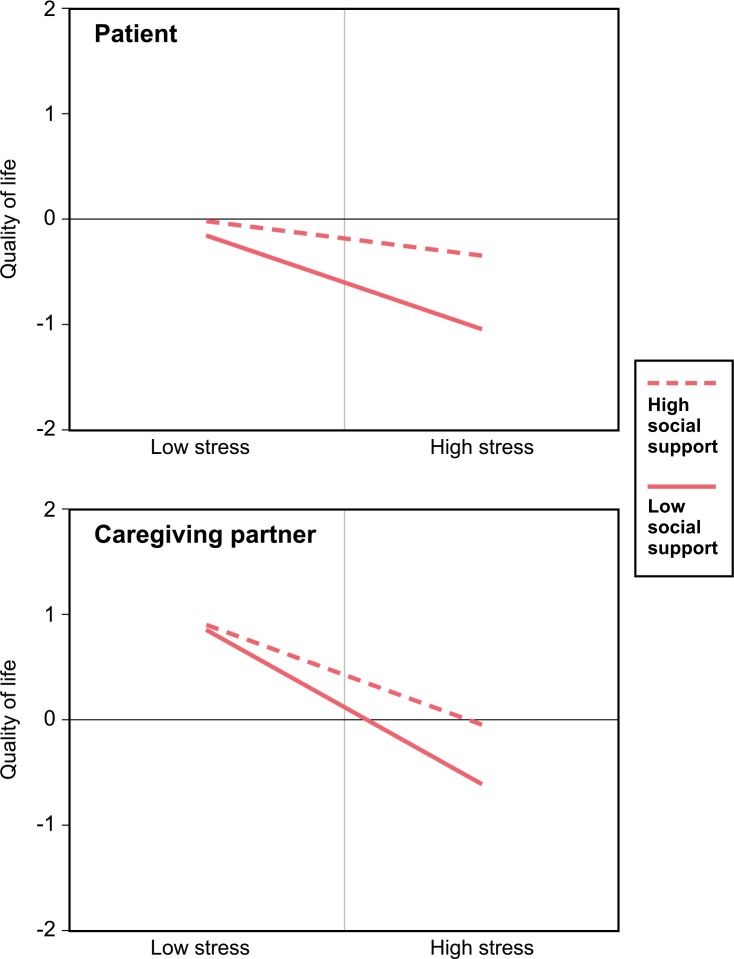
The stress-buffering effect of perceived social support on health-related quality of life separately for patients and their caregiving partners (Hypothesis 2).The solid line with diamond symbols represents predicted values from the adjusted mixed model of low perceived social support (one standard deviation below the mean); the dashed line with square symbols represents predicted values of high perceived social support (one standard deviation above the mean). Low perceived distress refers to values of one standard deviation below the mean; high perceived distress refers to values one standard deviation above the mean. All variables were centered with a mean value of zero (z-standardization).